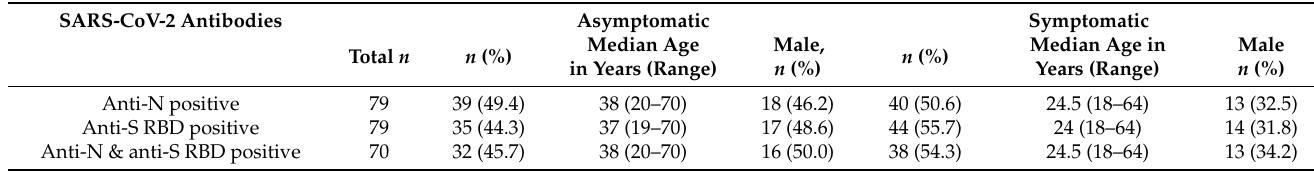
Table 3. Symptomatic status of participants positive for SARS-CoV-2 antibodies against N-protein, and receptor-binding domain